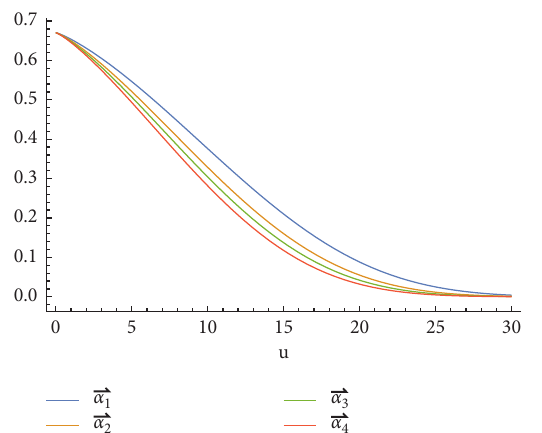
Figure 8: Curves of survival function F